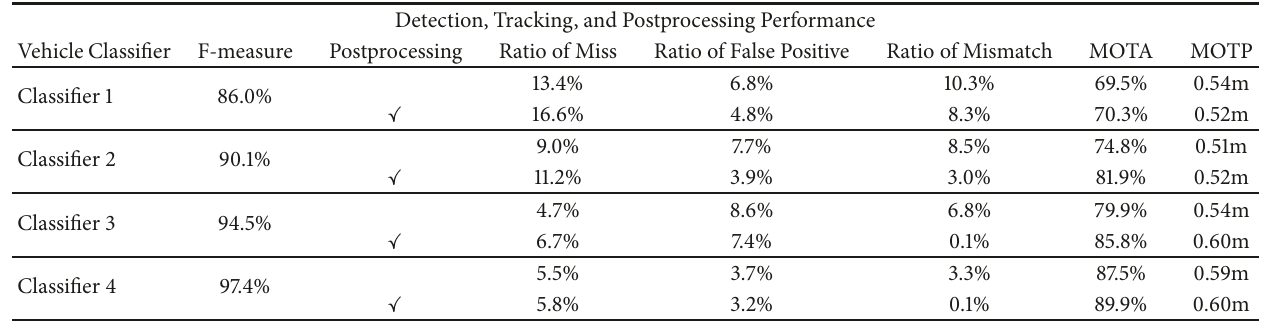
Table 3: Variation in tracking performance based on the detection performance and postprocessing.